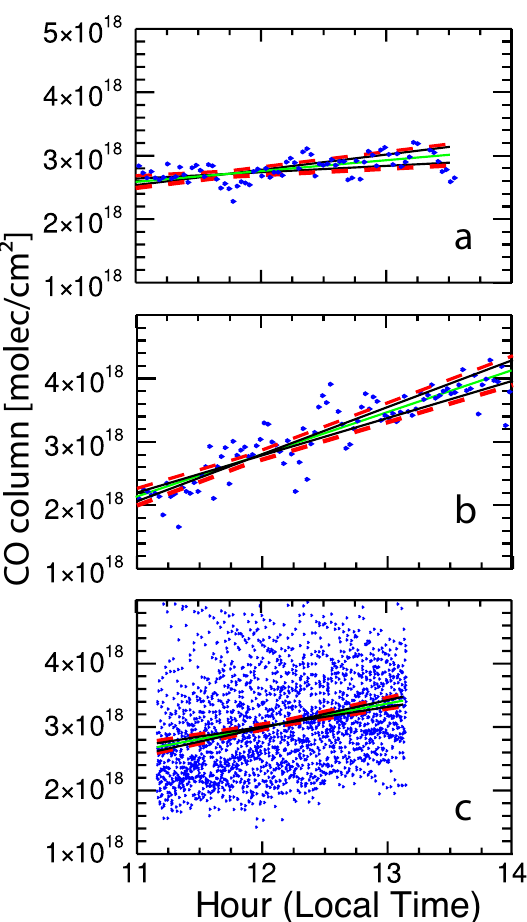
Fig. 5. Scatter plots of CO column measurements (blue dots) at UNAM on two typical days with low ventilation a) Sunday, 20 January 2008 and b) Monday, 21 January 2008, the following day. The linearly fitted growth-rates (green lines) reflect emission fluxes of (105 ± 13) (kg/km 2 h) and (309 ± 25)kg/(km 2 h), respectively. The CO column growth-rate between 11:15 and 13:15 LT on all days without ventilation is presented in c). Errors are taken from the 95% confidence interval drawn as the dashed red lines and their asymptotes (black lines). The latter indicates the error in the slope (growth-rate) which reflects the average emission flux of CO. The large dispersion originates from local or regional events as well as from a seasonal cycle, but the noise is compensated by the large dataset in c) and a significant value (174 ± 20) kg/(km 2 h) for the emission flux of CO is